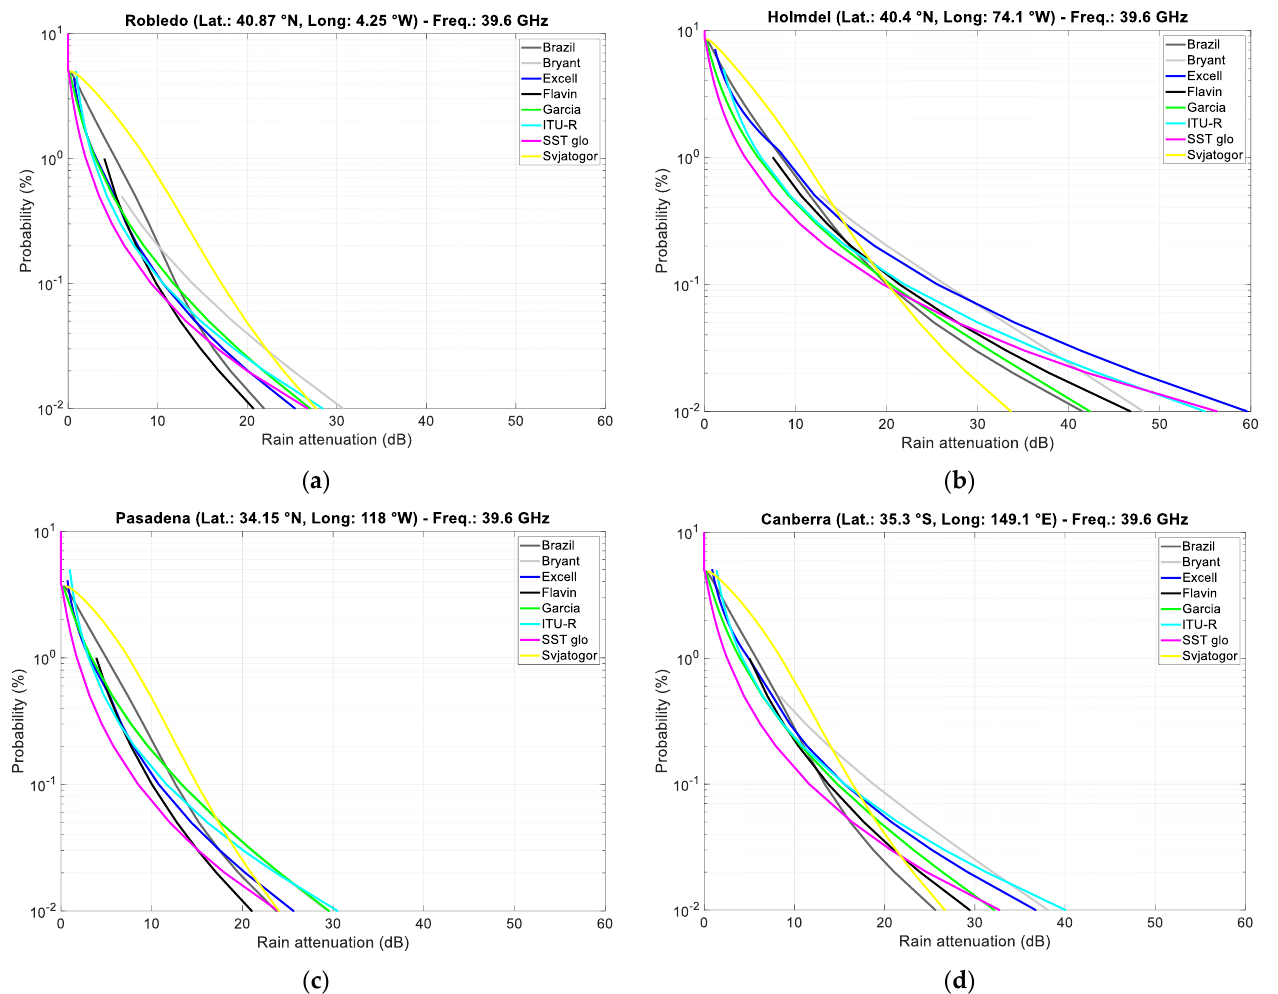
Figure 2. Annual probability distributions (%) of rain attenuation exceeded in the slant paths directed along the local meridian to a Geostationary satellite at 39.6 GHz and a circular polarization in: (a) Robledo (elevation angle 42.8°): (b) Holmdel (elevation angle 43.3°), (c) Pasadena (elevation angle 50.3°), and (d) Canberra (elevation angle 49.0), predicted by using the ITU − R [28,29] rain rate probability distributions.